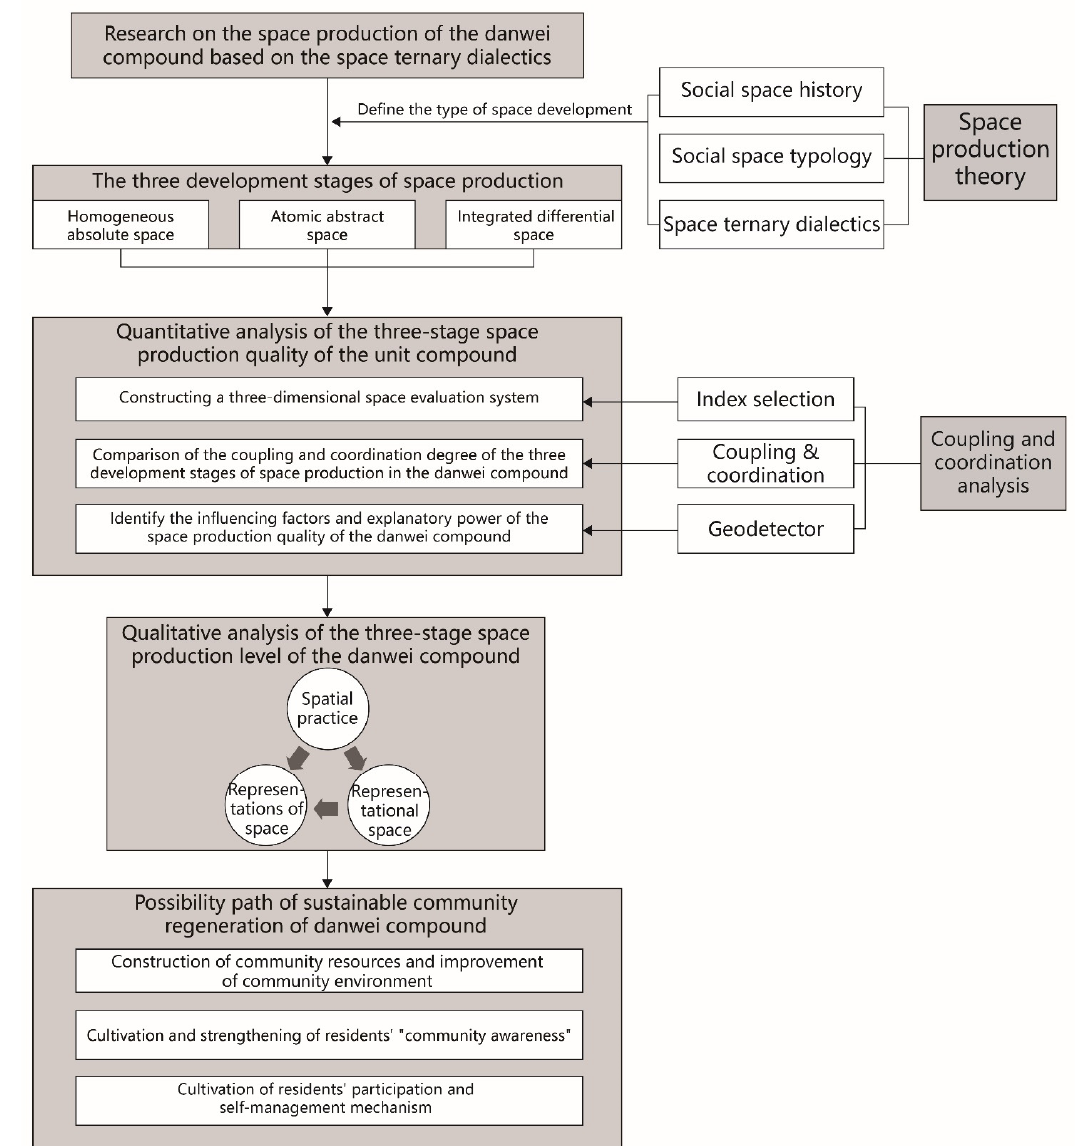
Figure 1. Framework diagram of research (source: self-drawn by one of the authors).